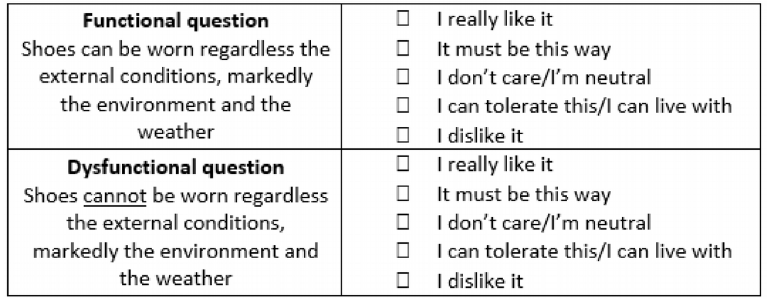
Figure 2. Illustrative functional and dysfunctional questions of Kano